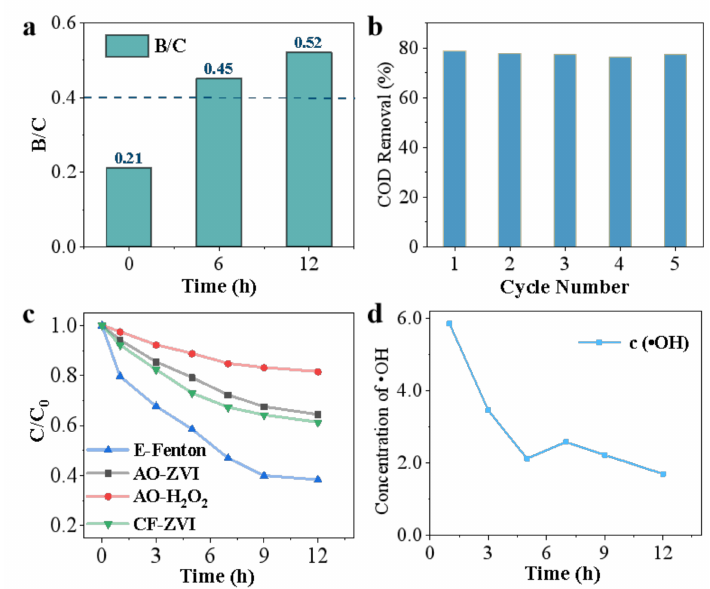
Figure 4. ( a ) Changes in the BOD 5 /COD ratio over treatment time; ( b ) Reusability of the anode material; ( c ) COD removal percentage changes in four treatment models: AO-H 2 O 2 , AO-ZVI, CF-ZVI, and E-Fenton processes. ( d ) Changes in the · OH concentration. Conditions: initial pH = 2.0, applied voltage = 3 V, iron powder = 1.2 g/L, Na 2 SO 4 concentration = 0.025